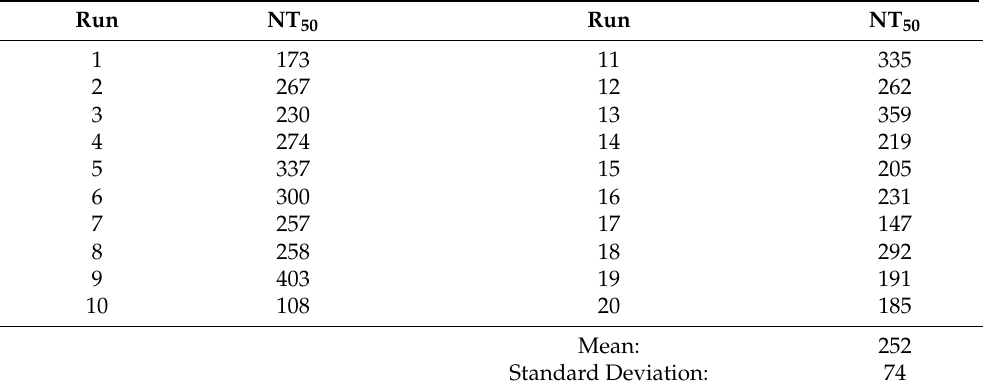
Table 6. FRNA experimental variability testing.